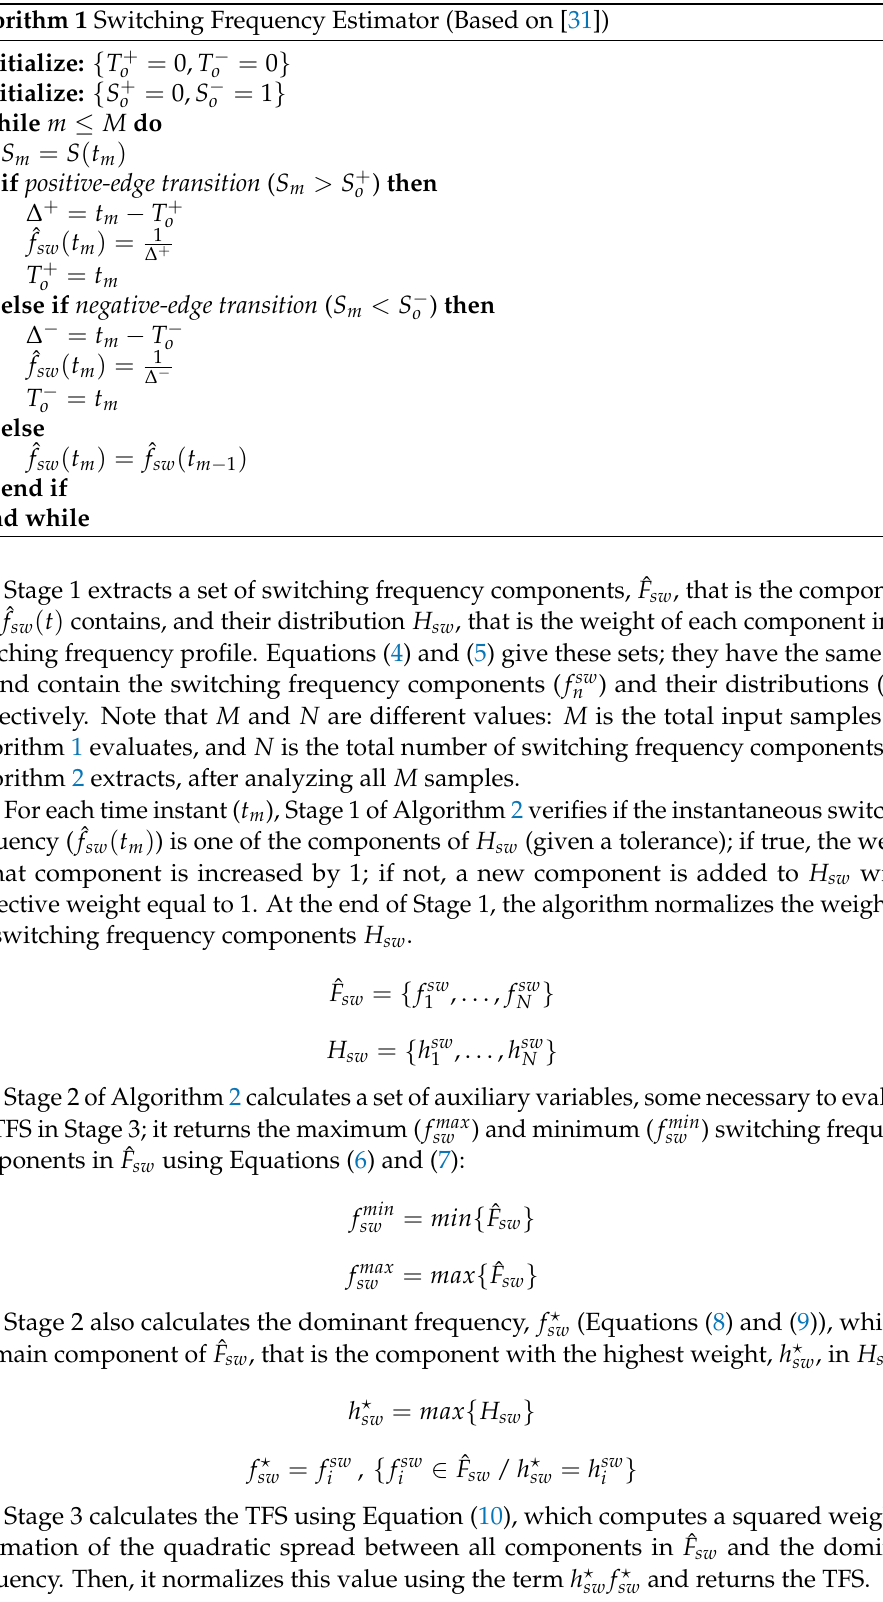
Algorithm 1 Switching Frequency Estimator (Based on [31])